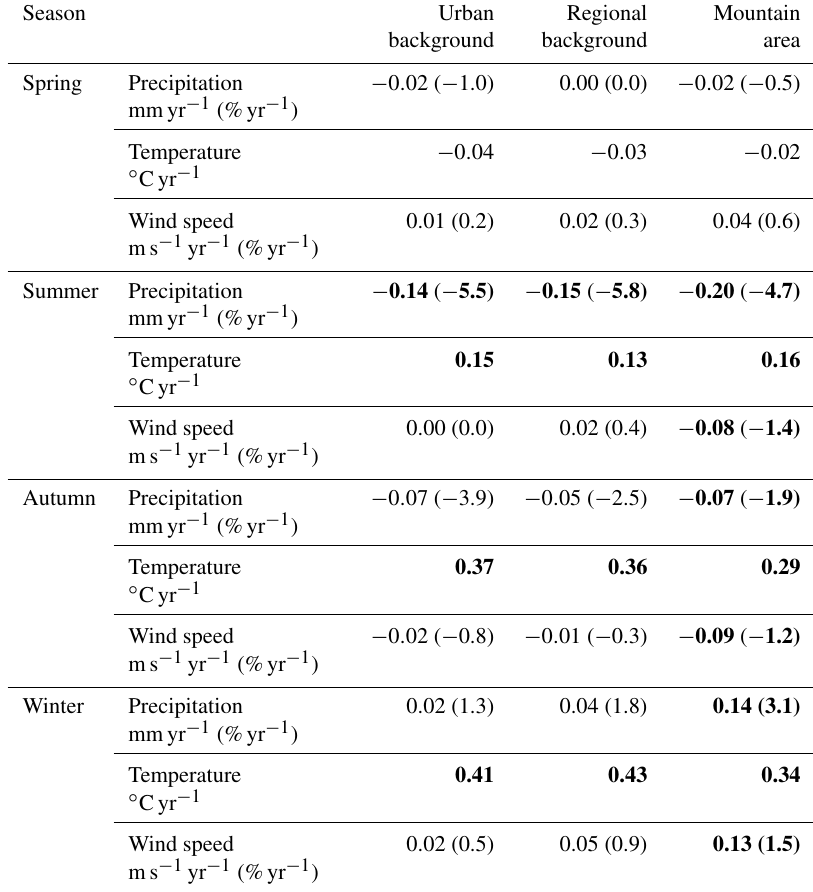
Table 5. Trends of meteorological parameters for the three site categories in Germany. The bold numbers are the statistically significant slopes at the 95% significance level. The daily meteorological data are from Germany’s National Meteorological Service (Deutscher Wetterdienst, DWD).